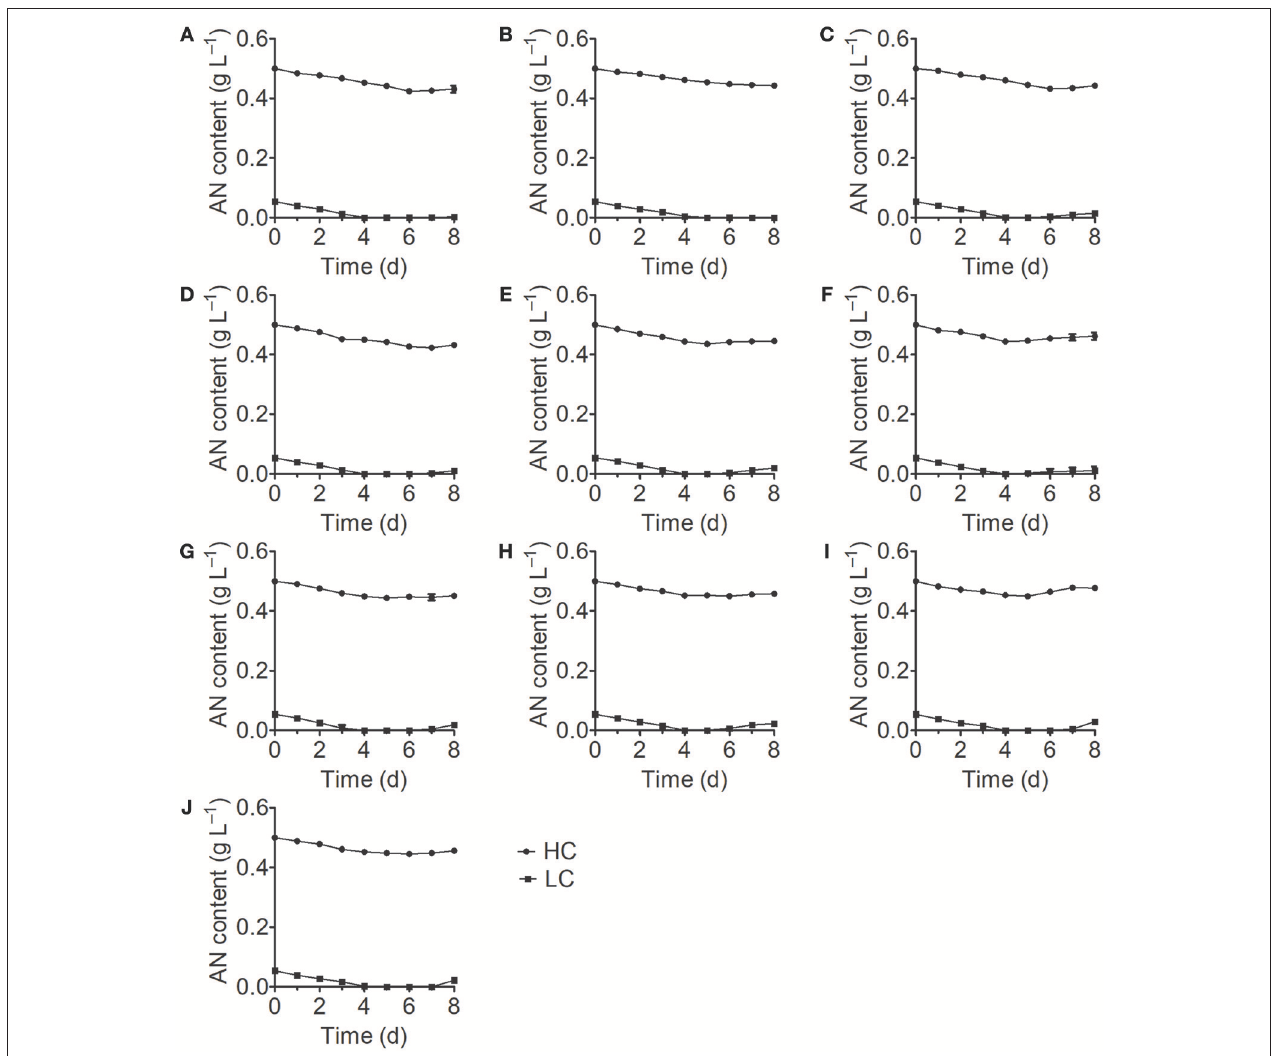
FIGURE 2 | Ammonium nitrogen (AN) content of 10 Chlorella strains cultivated in HC (circles) and LC (squares) medium. (A–J) Represent Chlorella strain FACHB-1, FACHB-1216, FACHB-1535, FACHB-1563, W1, W2, W3, W4, W5, and W6,